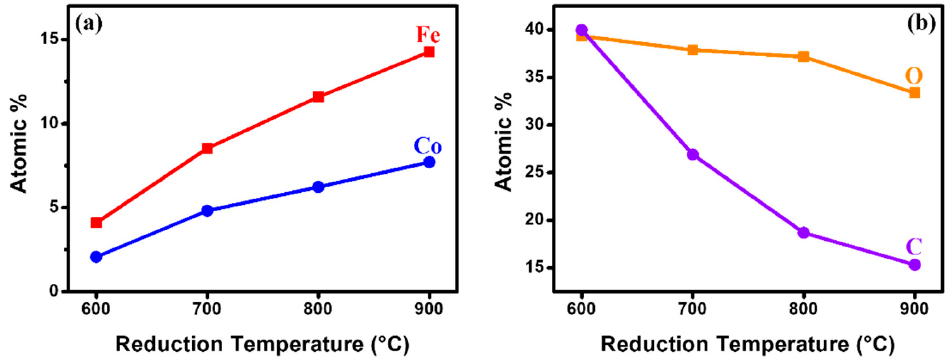
Figure 1. ( a ) Iron and Cobalt atomic % and ( b ) Oxygen and Carbon atomic % according to reduction temperature of the Fe–Co/MgO catalyst.